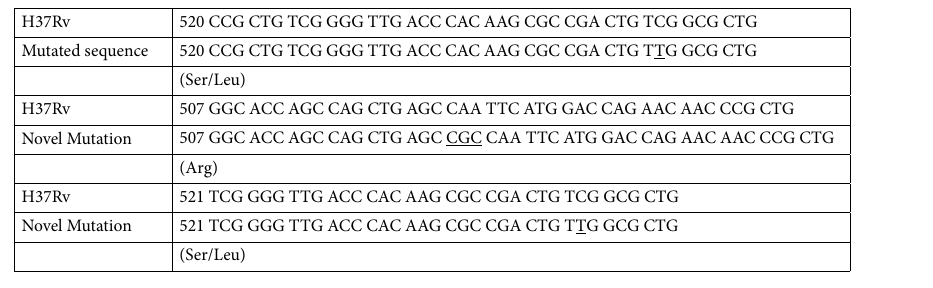
Table 3. Sequence comparison of rpo B gene (Mutation in hot